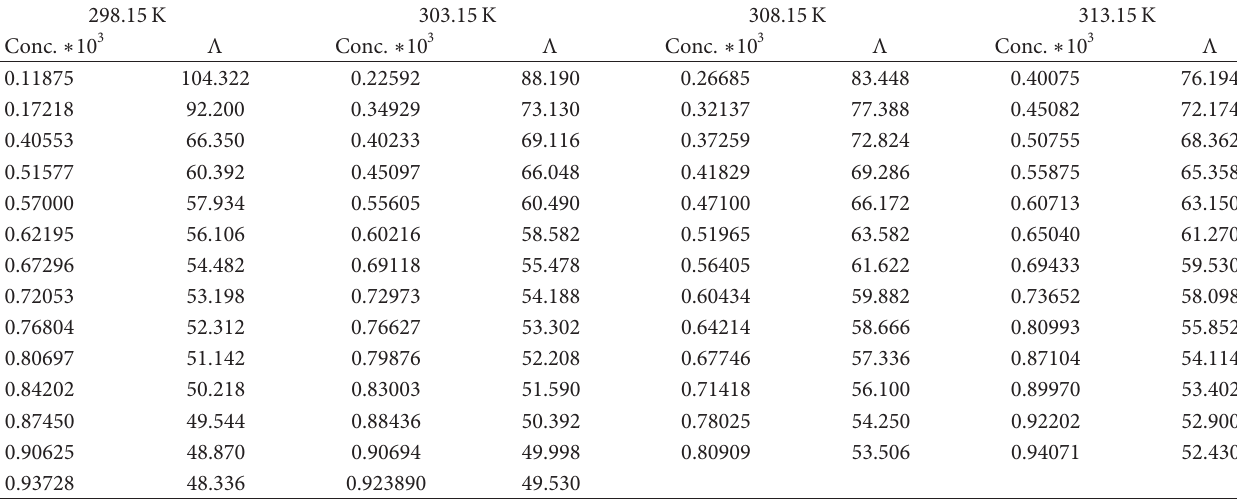
T 2: Experimental conductance data for Cu succinate.